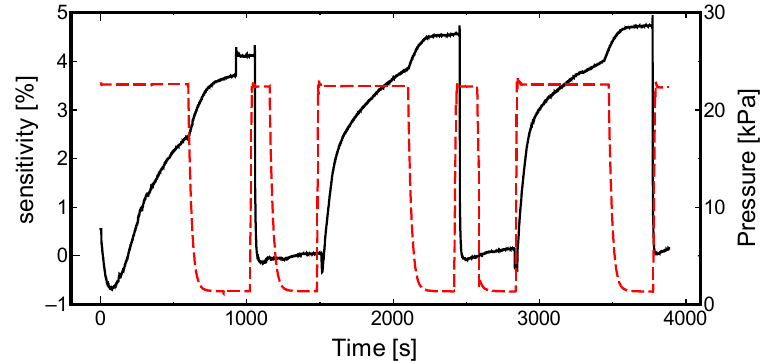
Figure 6. Sample 213-1 winter (less than 10 °C) sensitivity measurement.